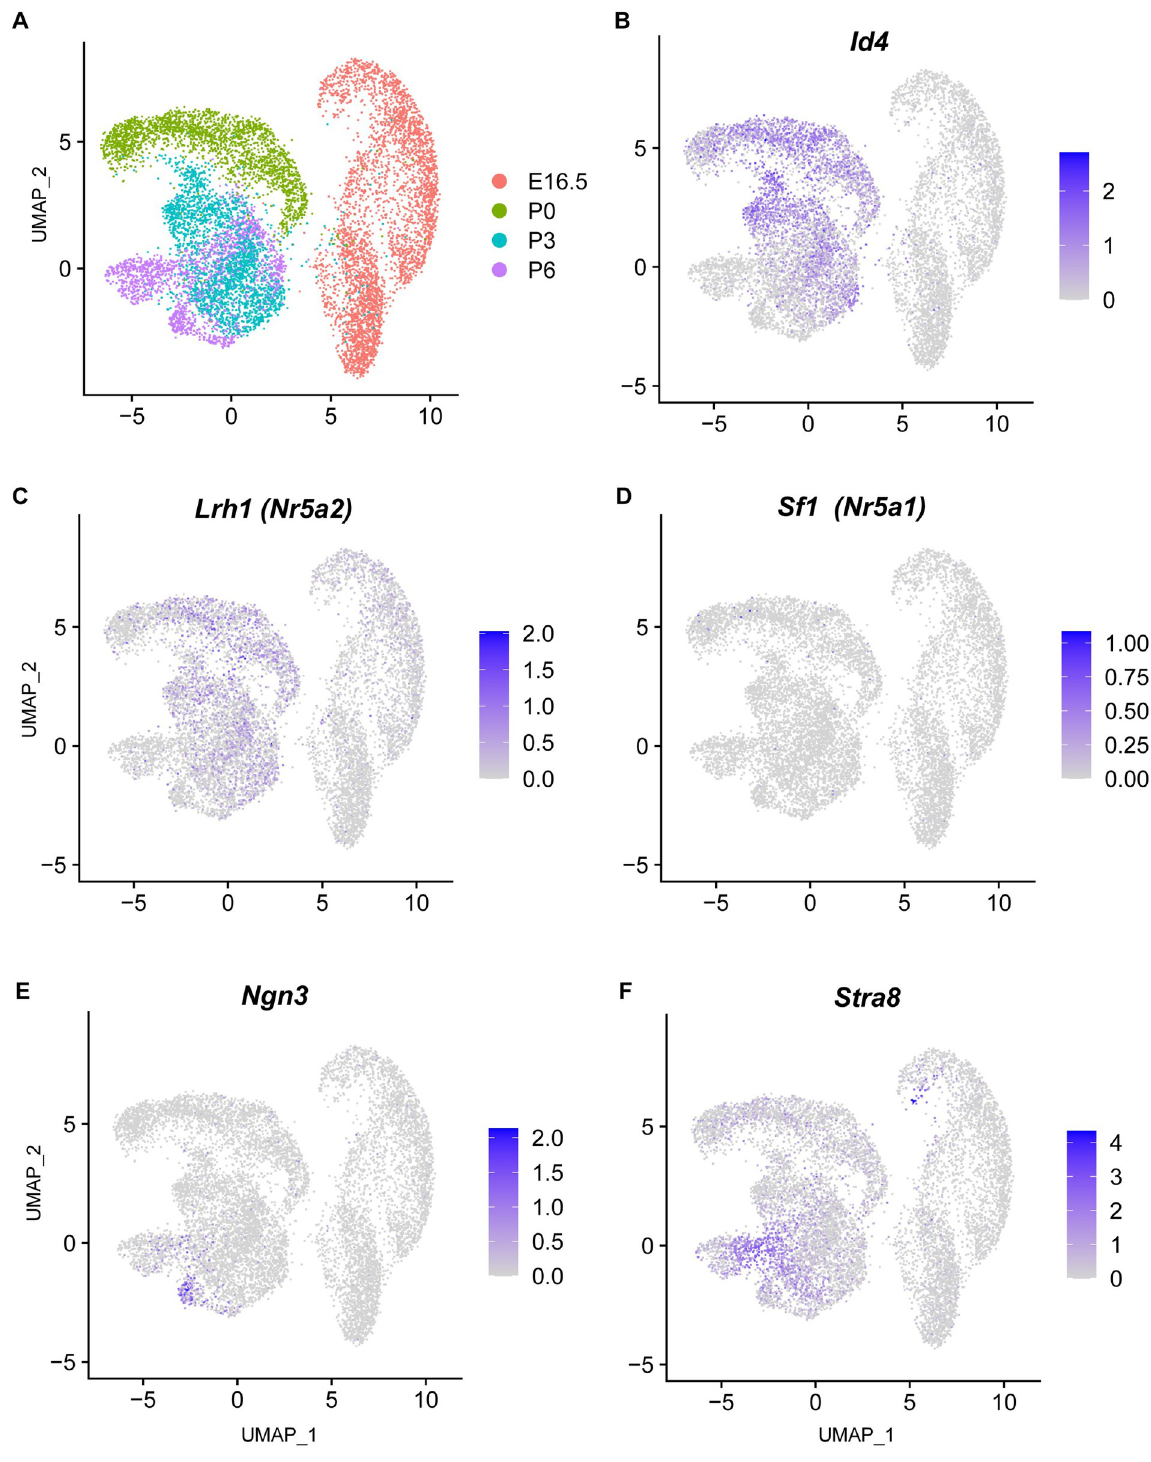
Fig 1. Lrh1 is expressed in presumptive SSCs and undifferentiated spermatogonia. Analysis of scRNA-seq data of Law and colleagues [42]. (A) UMAP projection of data from prospermatogonia and spermatogonia isolated at E16 through P6 with developmental stages color coded as indicated in key. (B-F) Expression of Id4 , Lrh1 , Sf1 , Ngn3 and Stra8 in isolated cells coded for expression level, with more intense blue color representing stronger expression.